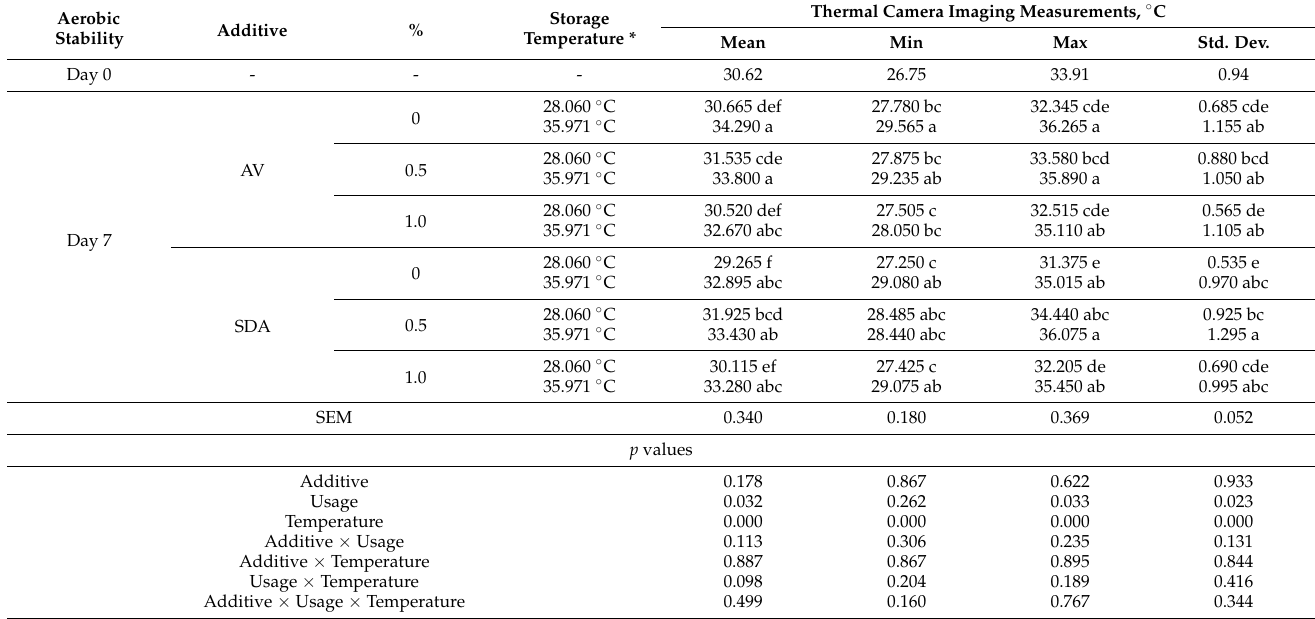
Table 8. Thermal camera imaging results of aerobic stability on day 7 (Ambient temperature = 22 ◦ C).